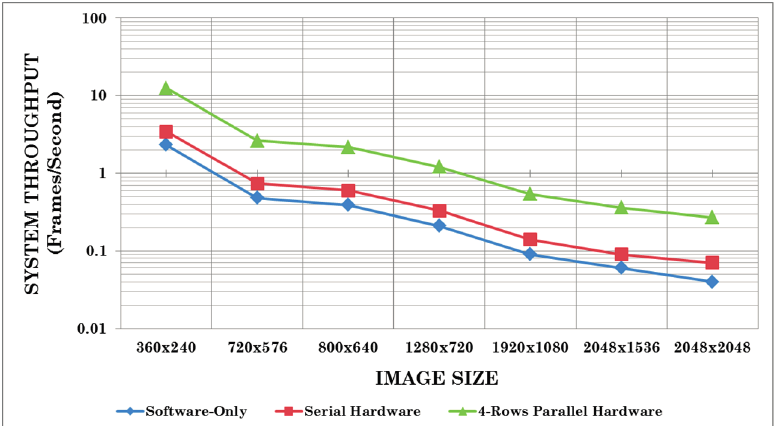
Figure 18. Comparative system throughput results in logarithmic scale (in frames/second) for the three prototype implementations of the fast adaptive binarization algorithm [32] on a Xilinx Virtex-6 FPGA for some common image